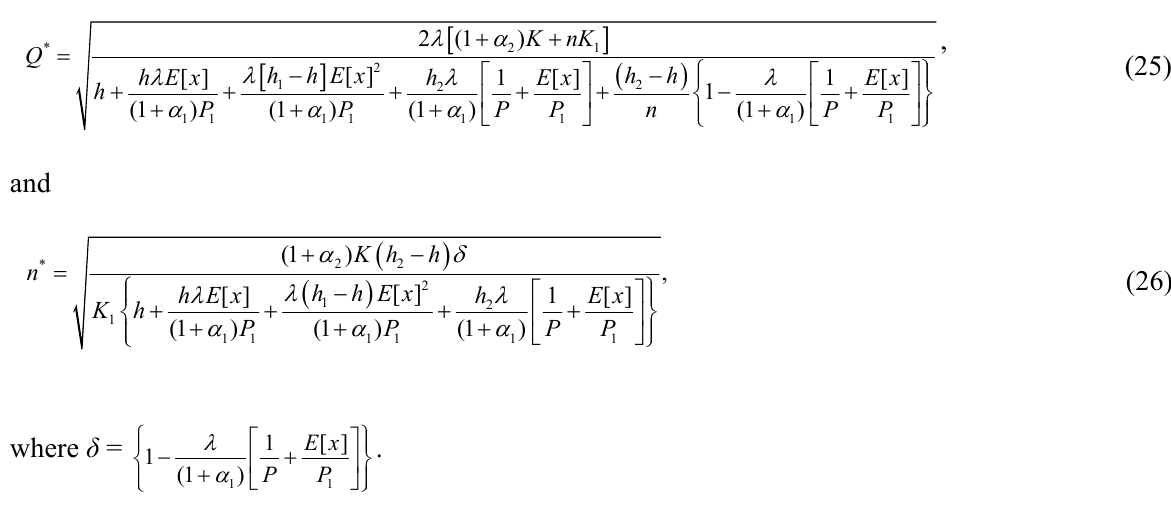
Fig. 5. Behavior of E [ TCU ( Q , n )] with respective to Q in the proposed EMQ-based system